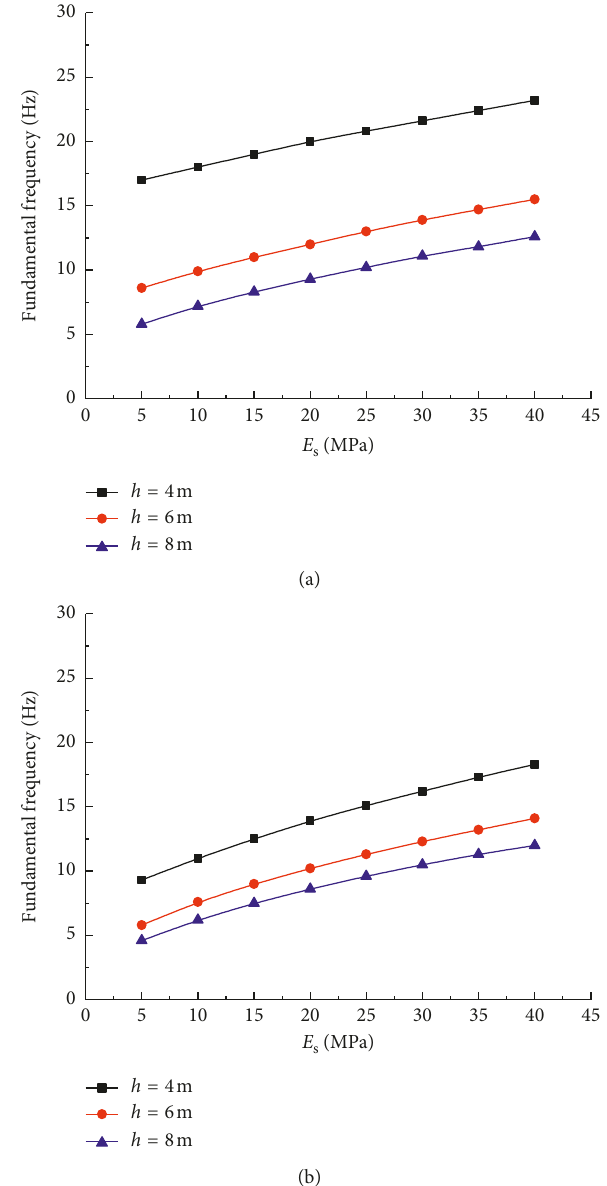
Figure 7: Effects of soil modulus on fundamental frequencies: (a) E � 25GPa; (b) E �